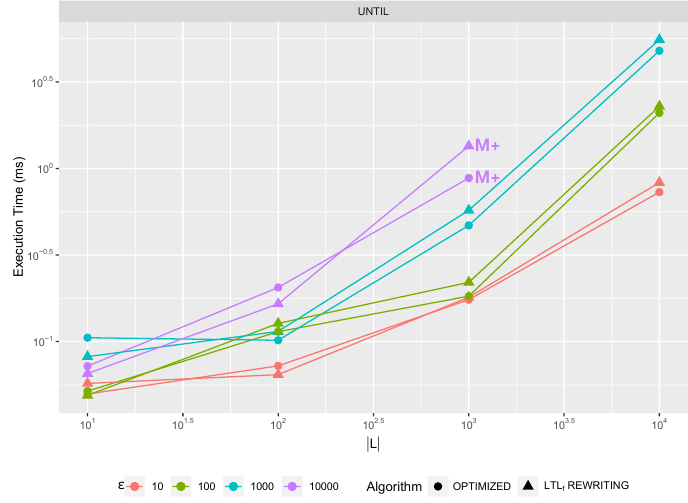
Figure 9. Results for the U NTIL operator (Section 6.3). Choice and Untimed Or . The next set of experiments is to evaluate the customary declarative clause implementation, where we hypothesise reformulating the semantics associated with Choice to provide performance gains from the absence of preliminary aggregations via the UntimedFuture operator. In fact, the proposed optimisation derives from the omittance of the Future operators for ρ 1 , ρ 2 , which formally comply with the logical definition. For the untimed Future Section 3.2.2 operator, bounded scans can be exploited, as the data are sorted with respect to trace id, and all the events that satisfy ρ for the current trace id are included in the result. Therefore, we expect an overhead that grows linearly with log size. Figure 8 shows that, in the best case ( (cid:101) = 10), we gain 0.5 orders of magnitude in performance. The findings affirm that log size has a greater influence on computational overhead than trace length. For (cid:101) ≥ 10 3 , the overhead resulting from the Future operators steadily increases while both the trace length (cid:101) and the log size |L| grows, albeit this is negligible in the logarithmic scale.